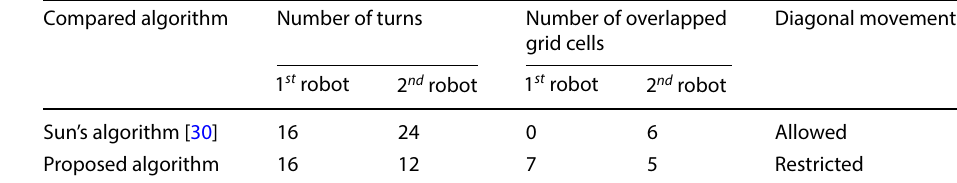
Table 10 Comparison of propose algorithm with Sun’s